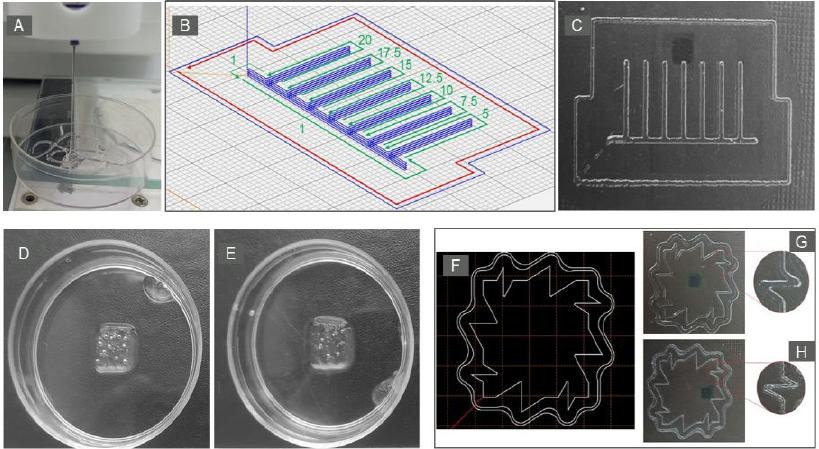
Figure 3. Printability of synthesized hydrogel. Formation of a 15% GelMA filament during extrusion through a 21G needle ( A ). The appearance of the maximum print speed estimation panel ( B ). The blue line marks the printed object, the red line marks the direction of ‘Skirt’ command printing at 1 mm/s, and the green line marks the direction of object printing at the speed range under study. The resulting panel ( C ). An example of an object printed from 15% GelMA before ( D ) and after a 72 h incubation ( E ). The appearance of the angled print panel ( F ) and the resulting panel at a speed of 5 mm/s ( G ) and 1 mm/s ( H ).